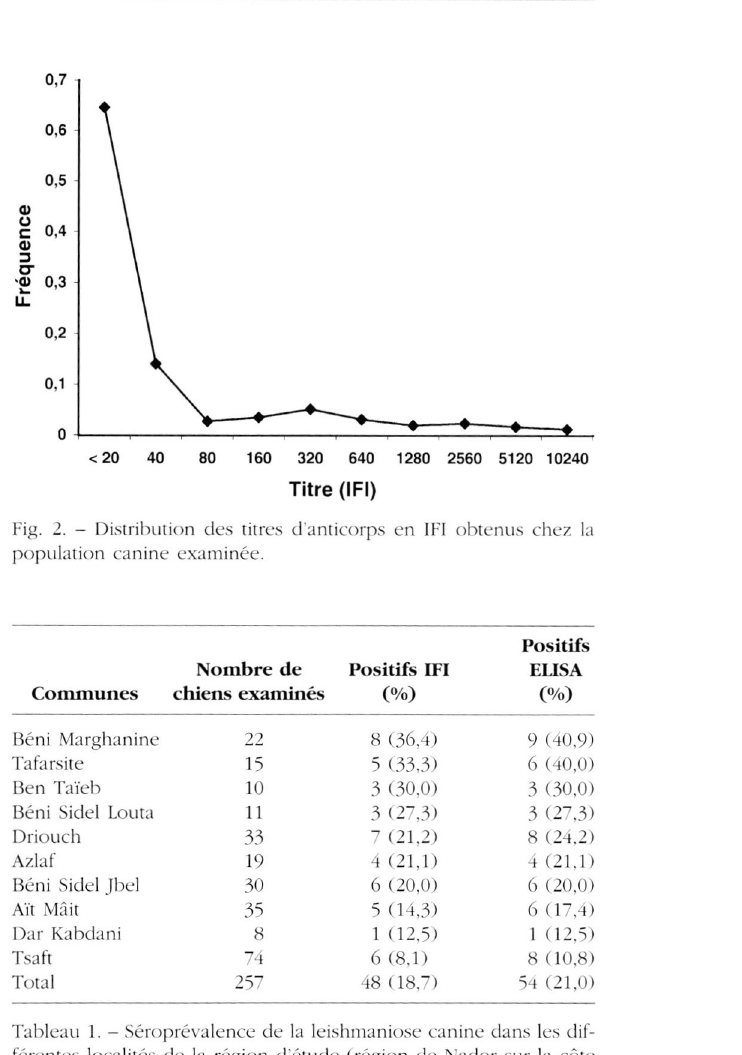
Tableau 1. - Séroprévalence de la leishmaniose canine dans les dif férentes localités de la région d'étude (région de Nador sur la côte méditerranéenne du